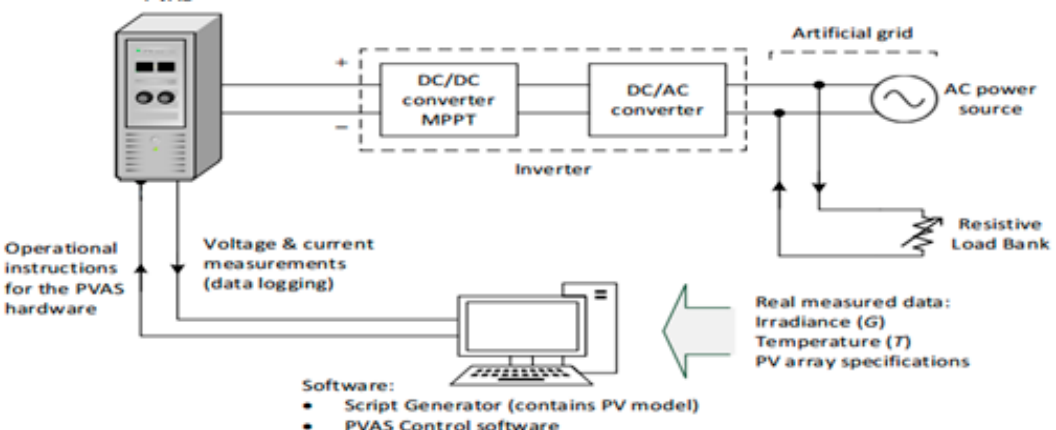
Figure 7. Block diagram of the PV inverter test.